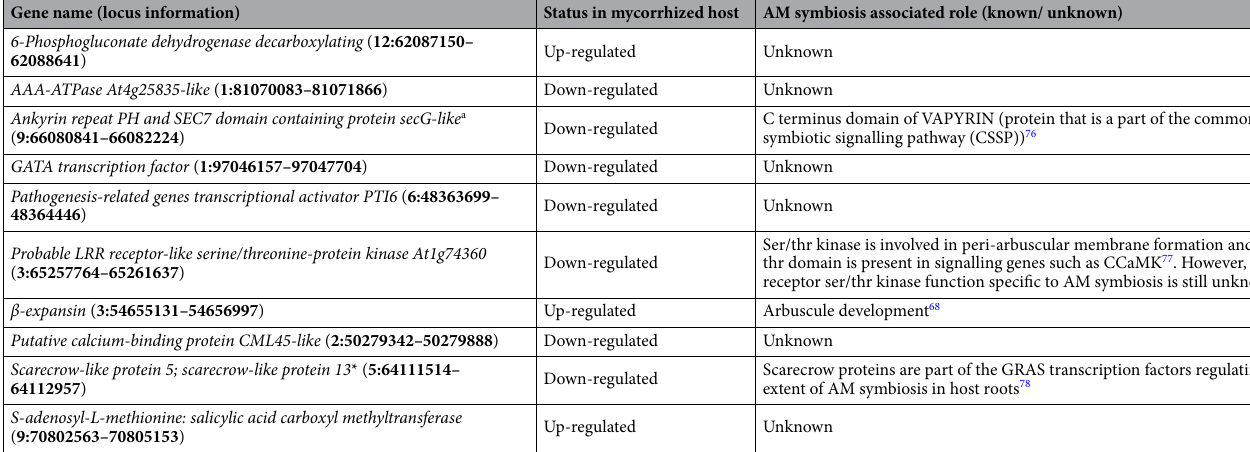
Table 1. List of putative novel gene candidates (set 1) used for phylogenetics and details of symbiotic-role. a Deviations from expected expression status observed in previously published